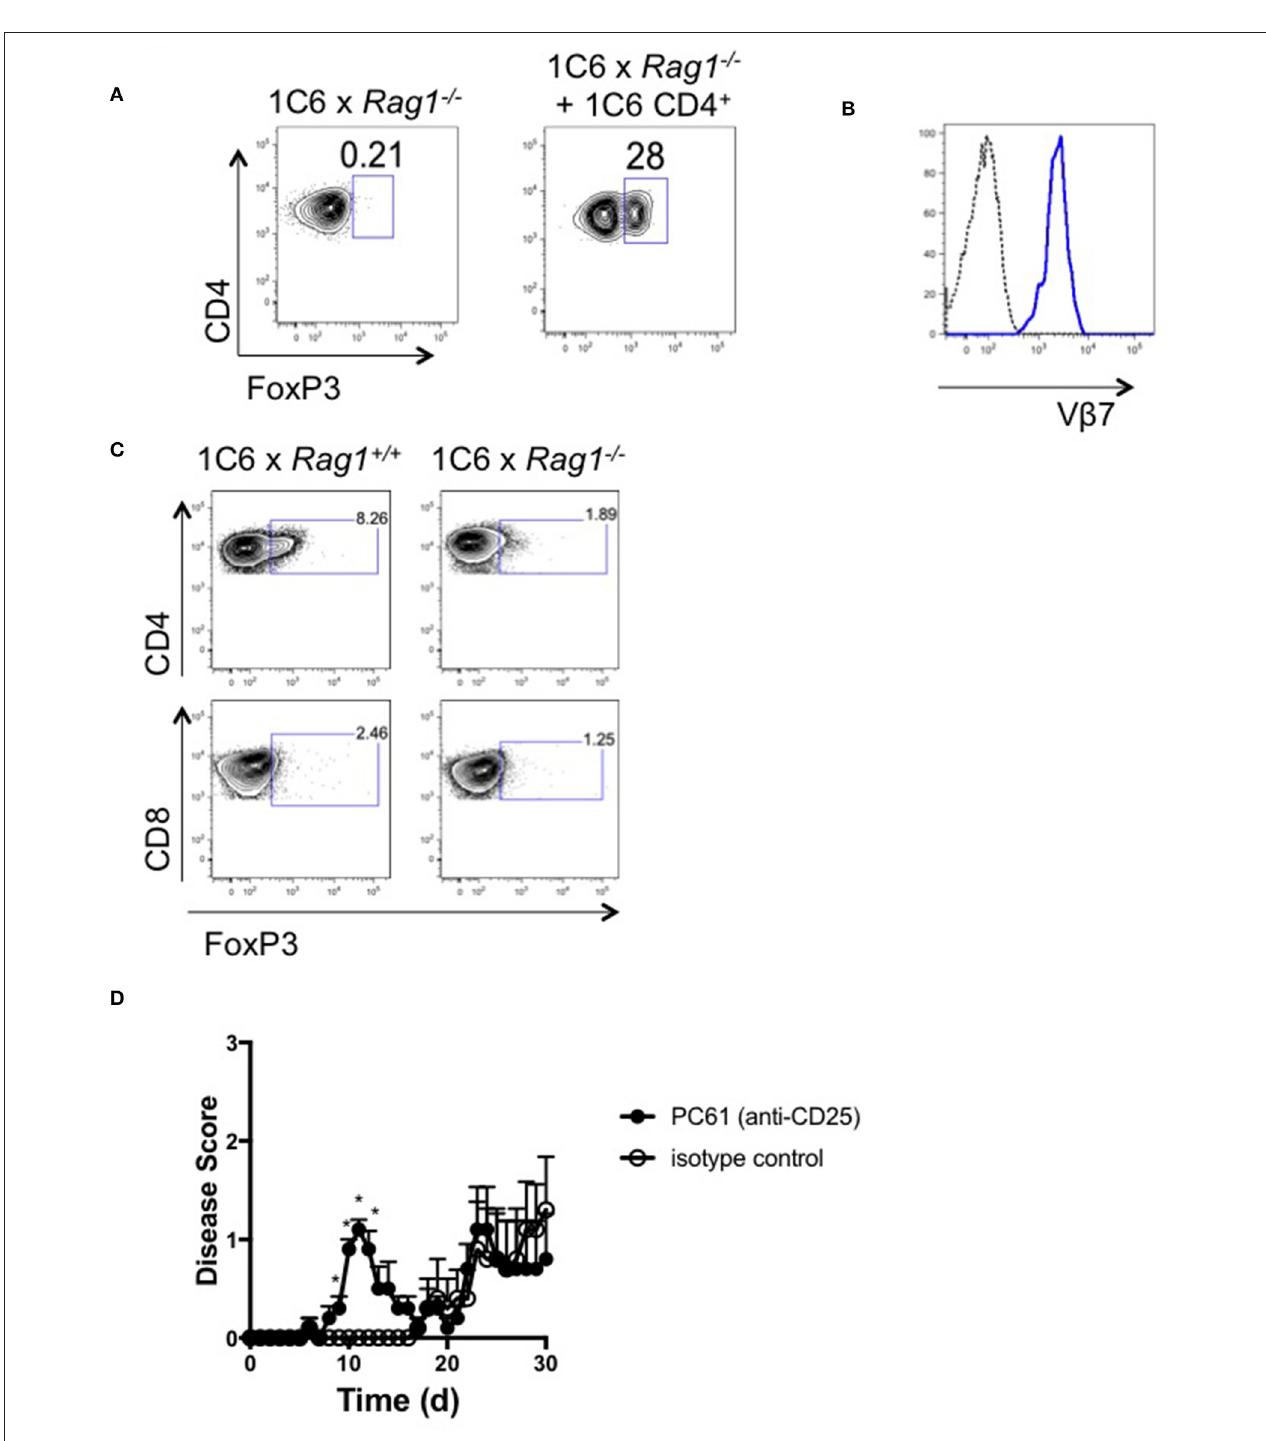
FIGURE 6 | FoxP3 + CD4 + T cells are absent from the CNS of 1C6 × Rag1 − / − mice with EAE. (A,B) . Female 1C6 × Rag1 − / − mice were reconstituted, or not, with 2 × 10 6 CD4 + T cells from unmanipulated 1C6 mice. After 14 days, mice were actively immunized with MOG [35 − 55] . At experimental endpoints, CNS-infiltrating CD4 + T cells were assessed by flow cytometry for expression of FoxP3 (A) . Representative data, n = 4 each group. (B) V β 7 expression (blue line) on CNS-infiltrating CD4 + FoxP3 + T cells from a 1C6 × Rag1 − / − mouse reconstituted with 1C6 CD4 + T cells. Dotted line, FMO control. (C) Female 1C6 and 1C6 × Rag1 − / − mice were actively immunized with MOG [35 − 55] . Lymph node T cells were isolated at the peak of disease and assessed by flow cytometry for FoxP3 expression. Gated on CD4 + (top) or CD8 + (bottom) events. Representative of 5 mice each. (D) Male 1C6 mice were treated with Treg-depleting anti-CD25 antibody (PC61) or with isotype control on days − 11, − 9, and − 7, and were immunized with MOG [35 − 55] on d0. n = 5, both groups. * p < 0.05 on individual days, Mann-Whitney U test.